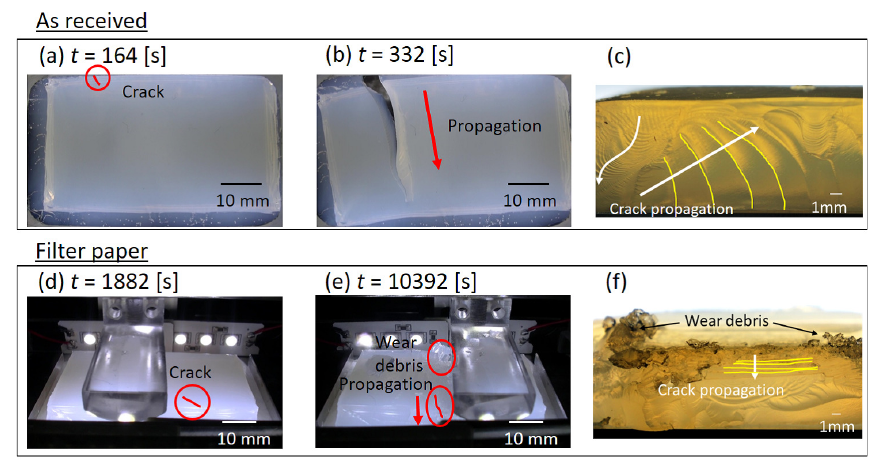
Figure 3. Fatigue crack behavior in As received ( a – c ) and Filter paper samples ( d – f ). ( a , b ) Bottom views, ( d , e ) side views, and ( c , f ) fracture surfaces after entire rupture of the samples. Small cracks are highlighted with red lines in ( a , d , e ). Arrows in ( c , f ) are crack paths, and yellow lines are supplementally drawn on striation